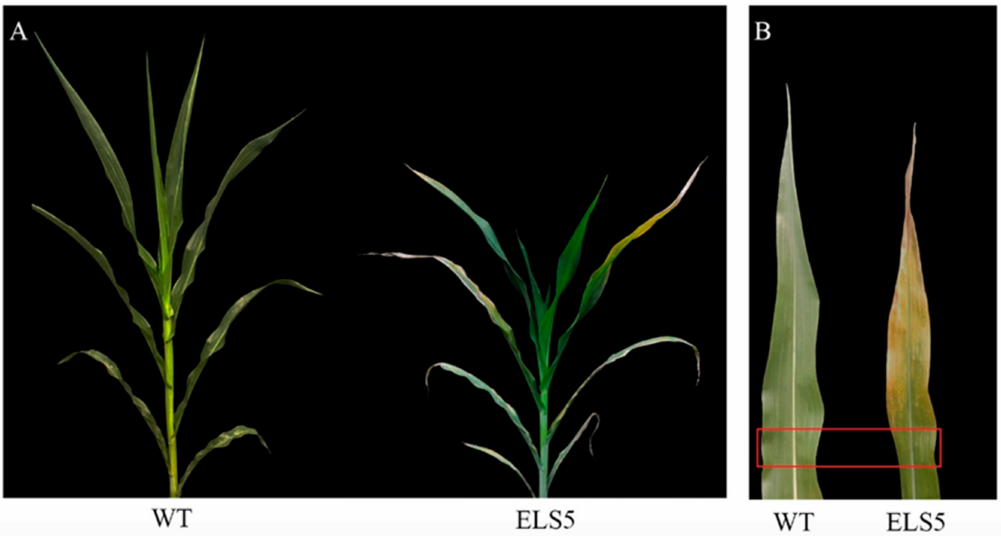
Figure 1. Phenotyping of wild-type (WT) and ZmELS5 near-isogenic lines (NILs) at V13 stage: ( A ) Whole plant of WT and ZmELS5 NILs at V13 stage; ( B ) the 11th leaf phenotype of the WT and ZmELS5 NILs at V13 stage.